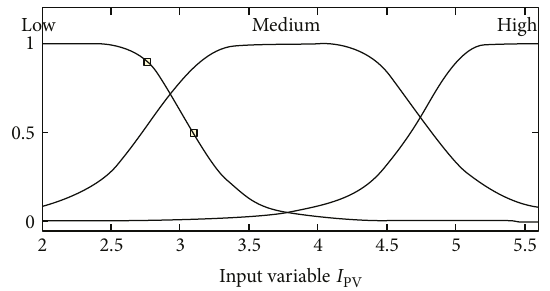
Figure 9: The membership function of the input variable ( I